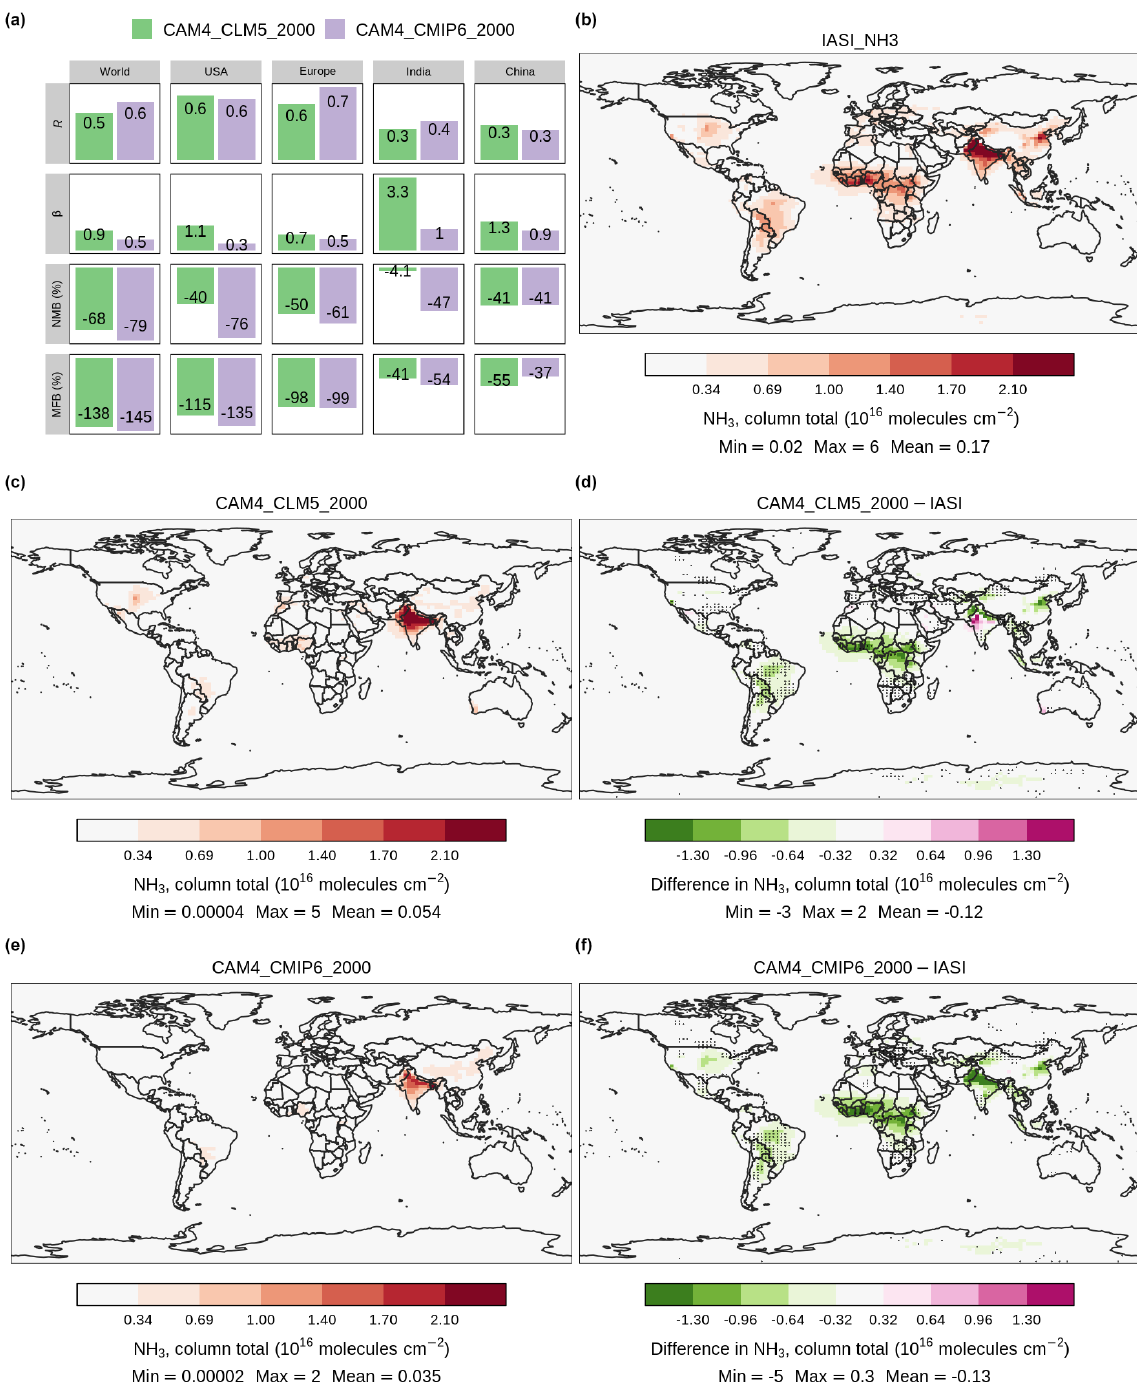
Figure 4. Annual-mean atmospheric NH 3 estimated by CAM4-chem with online CLM5 simulation and CMIP6 emission inventory as inputs of fertilizer-induced NH 3 emission, which are aliased as [CAM4_CLM5_2000] and [CAM4_CMIP6_2000], respectively. Panel (a) summa- rizes the correlation analysis between the two simulations and the IASI satellite retrievals. Panels (b) , (c) , and (e) show the column NH 3 concentration of IASI and the two cases correspondingly. Panels (d) and (f) show concentration differences between each case and the IASI observations. Overlaying black dots in the difference maps indicate grid cells with a high statistically significant spatiotemporal correlation (i.e., R 2 > 50%, p < 0 . 05) between CLM5 and IASI. Color scales are saturated at respective values, and ranges of values are shown in the legend